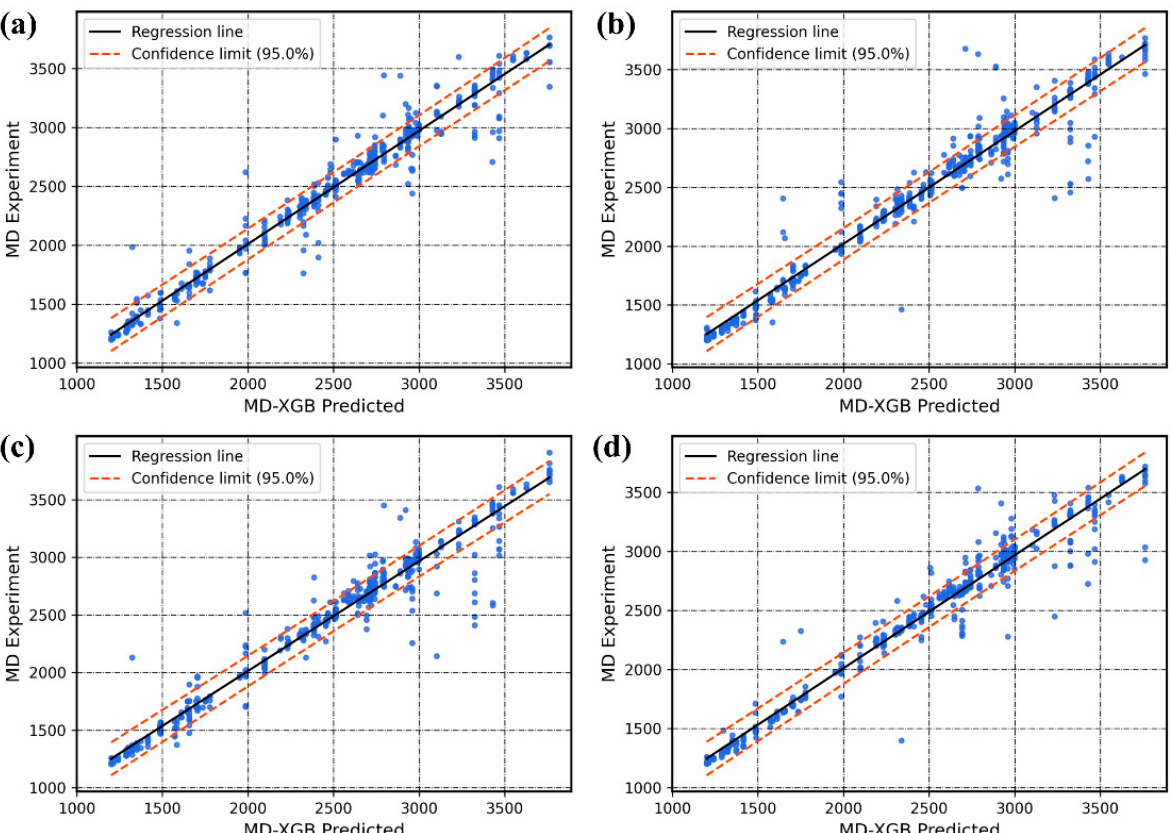
Figure 5. Sample regression plots comparing the MD experimental data with the MD-XGB predictions. Each plot in ( a )–( d ) corresponds to a different split of the training and test data. The R 2 and Cov values corresponding to each plot are ( a ) R 2 = 0.960, Cov = 0.916; ( b ) R 2 = 0.962, Cov = 0.863; ( c ) R 2 = 0.962, Cov = 0.898; ( d ) R 2 = 0.968, Cov = 0.897.